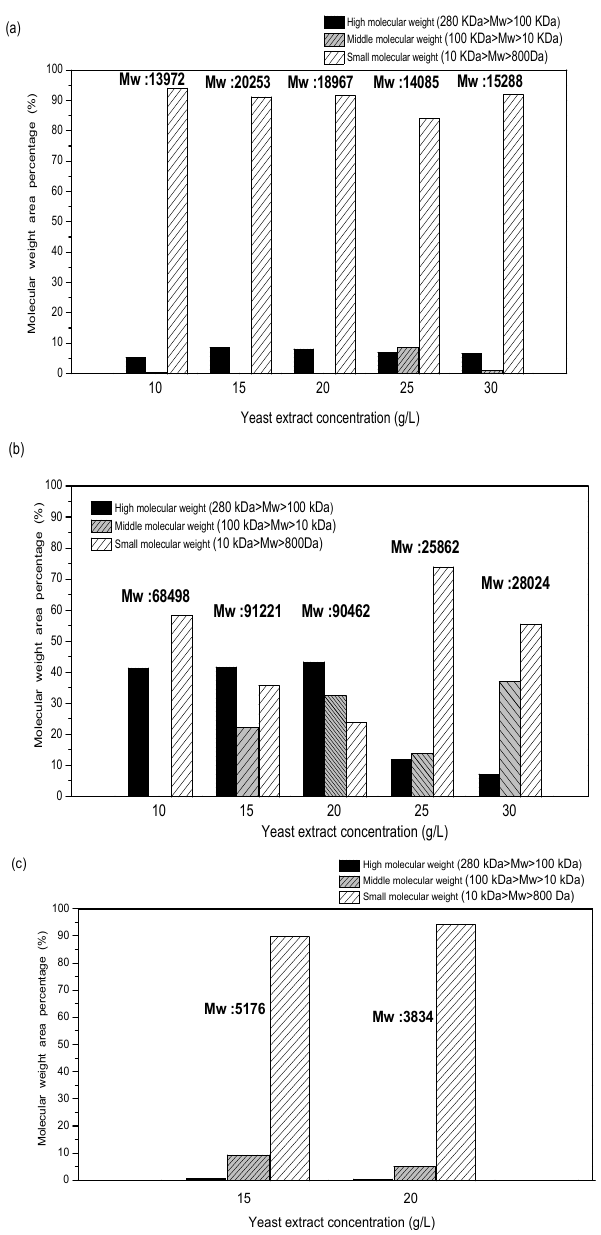
Figure 6. Molecular weight distribution of ( a ) water-extracted, ( b ) NaOH-extracted, and ( c ) HCl-extracted EPS produced at different concentrations of yeast extract.